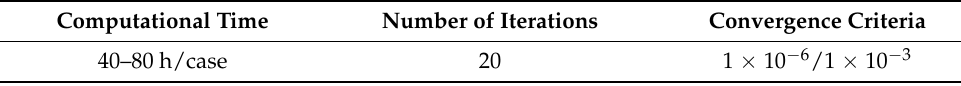
Table 1. Key information of the model implementation.